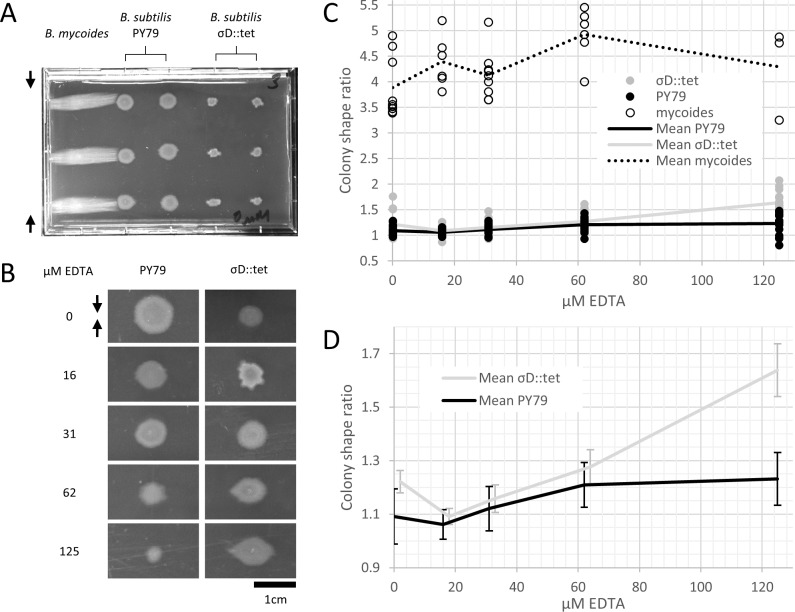
B. mycoides and B. subtilis colony morphology under compression.(A) A microtiter plate inoculated with B. mycoides and B. subtilis. The two white bars at the top of the image of the plate are polystyrene spacers, totaling 4.8% of the plate height. Black arrows indicate direction of compression throughout. (B) Representative images of B. subtilis PY79 and σD::tet colonies grown on compressed agar with varying EDTA concentrations. Scale bar, 1 cm. (C) Plot of colony shape ratio (i.e., colony measurement perpendicular to the dimension of compression/colony measurement parallel to the dimension of compression) as it varies with EDTA concentration. (D) Same as in C but with axes scaled to emphasize relative effect of PY79 and σD::tet, individual data points removed, and 95% CI error bars added. The σD::tet data has been shifted by 2 x-axis units to better display the error bars. For each condition, n > 11. Source data for this figure can be found in Data S1.